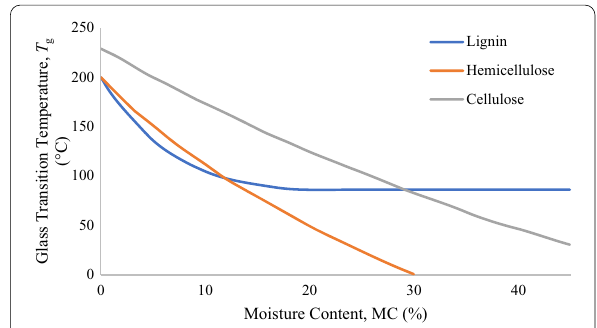
Fig. 3 T g vs MC of timber constituents (reproduced from [15])